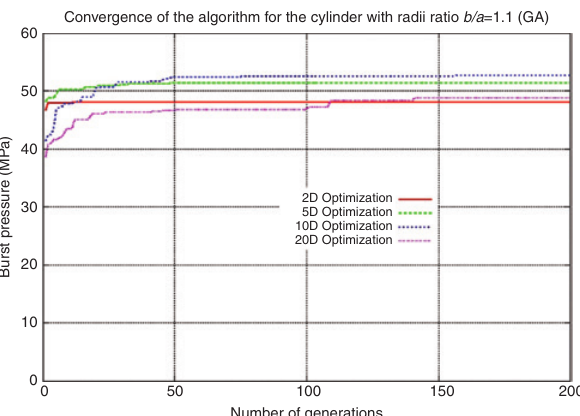
Figure 3: Convergence of GA algorithm for the pressure vessel with a radii ratio b / a = 1.1.